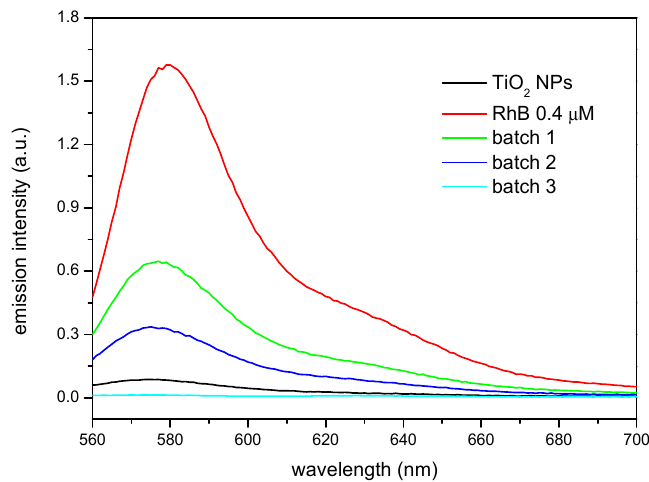
Figure 5. Fluorescence spectra of supernatants in contact with the as-received TiO 2 NPs and β CDTiO 2 NPs (batches 1, 2, and 3). The spectrum of the reference solution 4 × 10 − 7 M RhB is included for comparison purposes.